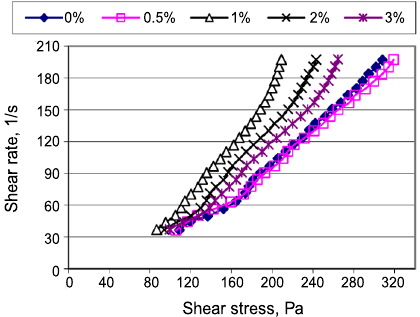
Fig. 6. Cement paste with CEM II R cement shear stress vs shear rate after mixing